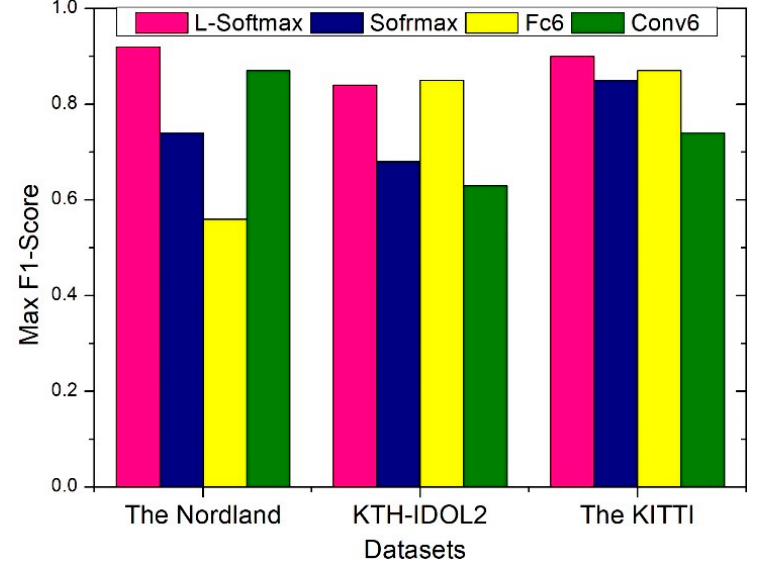
Figure 11. Different back-end components show different performance. Four kinds of structures have the same front-end and middle-end, in which VGG modules and Inception-A modules are included.